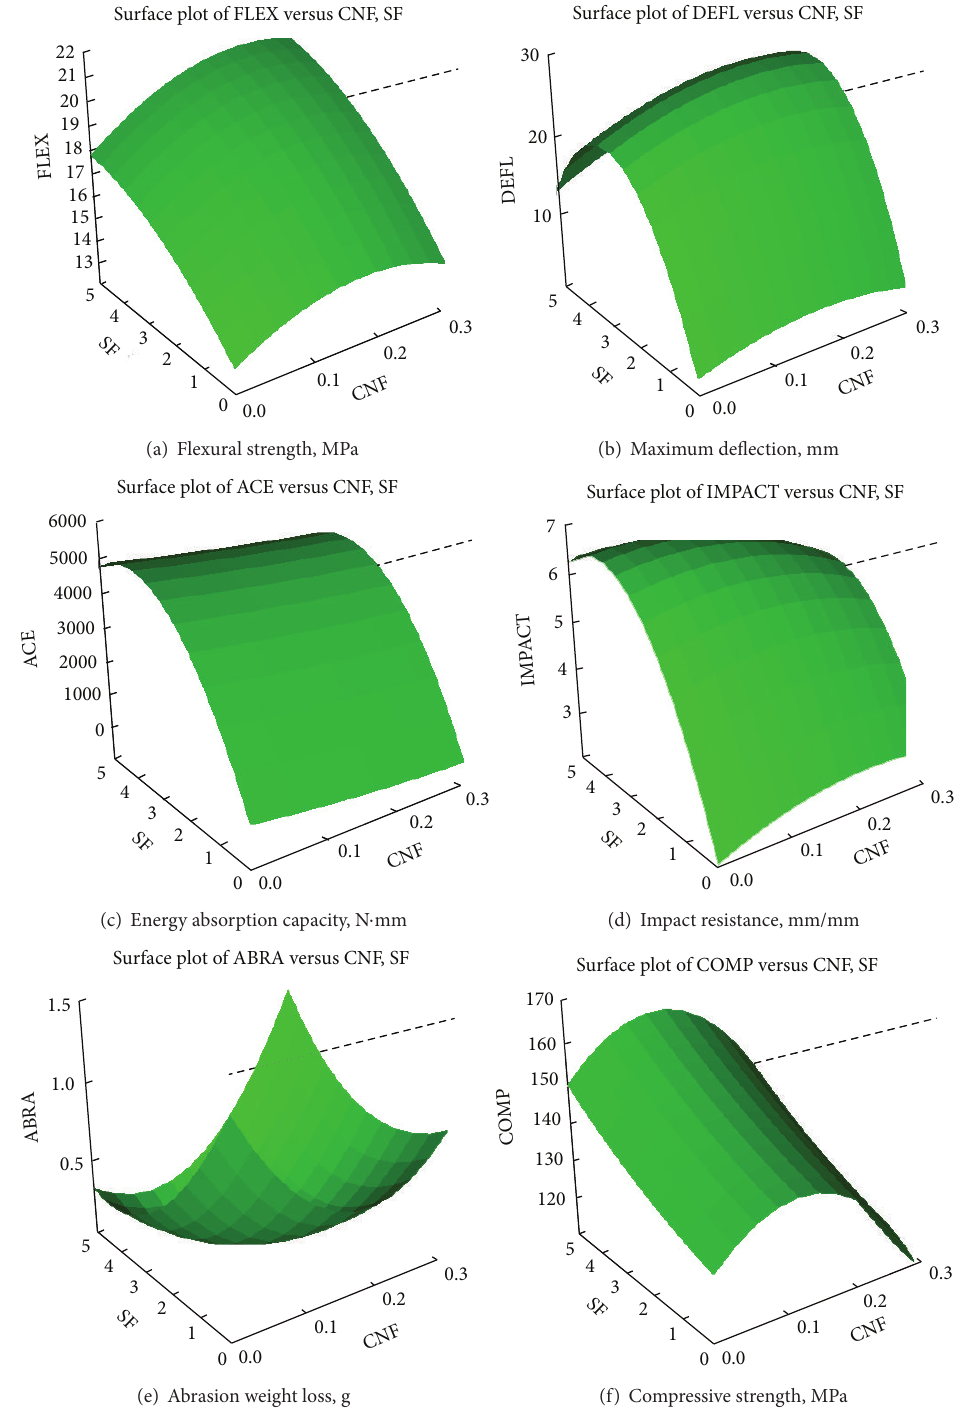
Figure 8: Response surfaces developed using the experimental results (CNF: carbon nanofiber, SF: steel